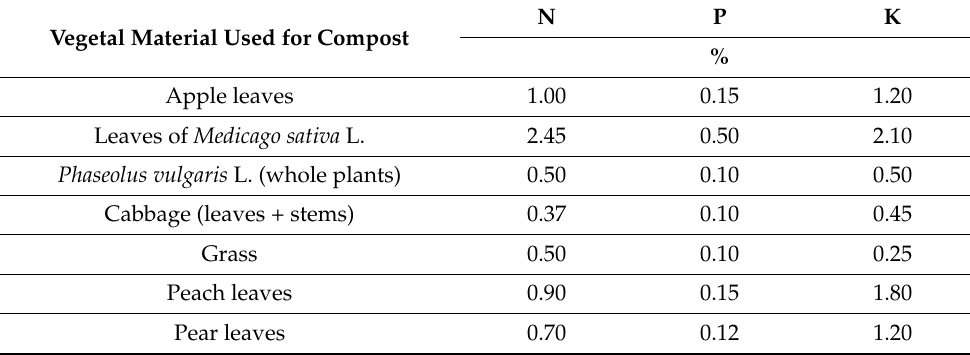
Table 3. Vegetal residues of some plant species that can be used for compost production (from Therios, 1996)